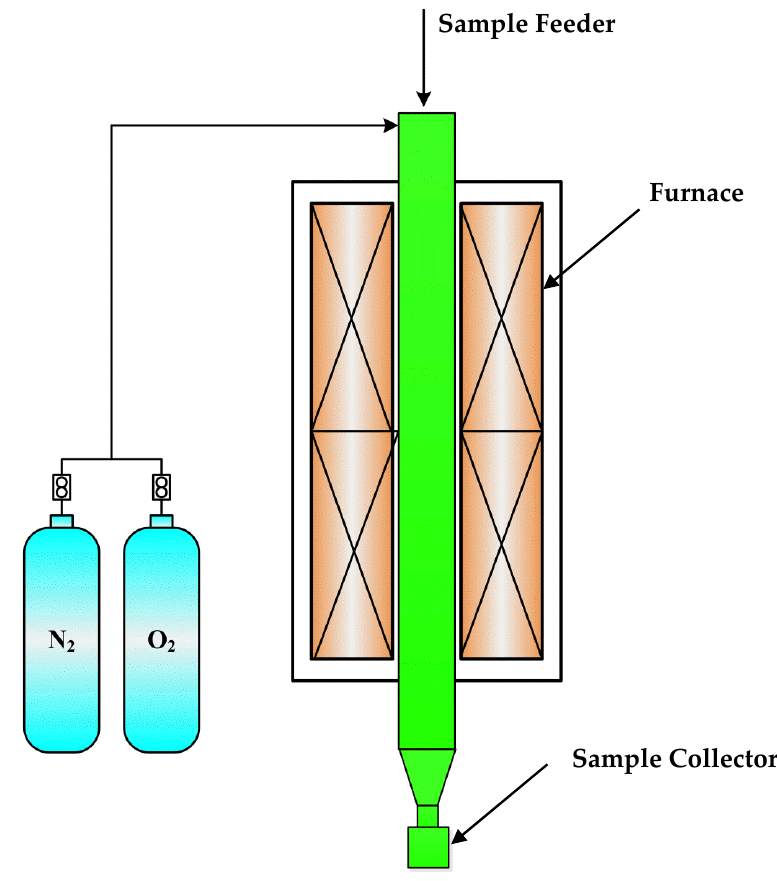
Figure 3. Schematic diagram of the drop-tube furnace system.